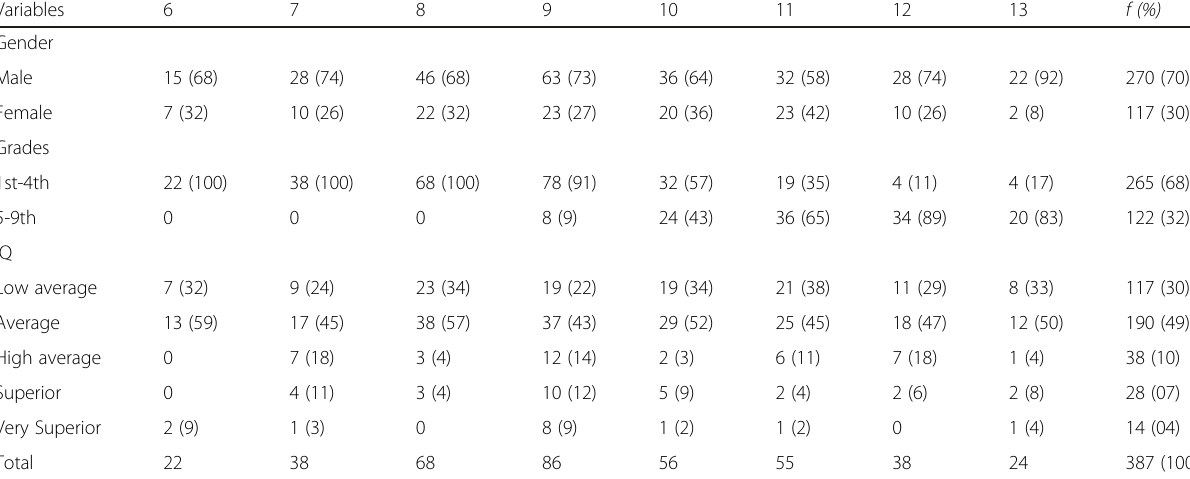
Table 1 Distribution of ages groups by gender, grades and intellectual level